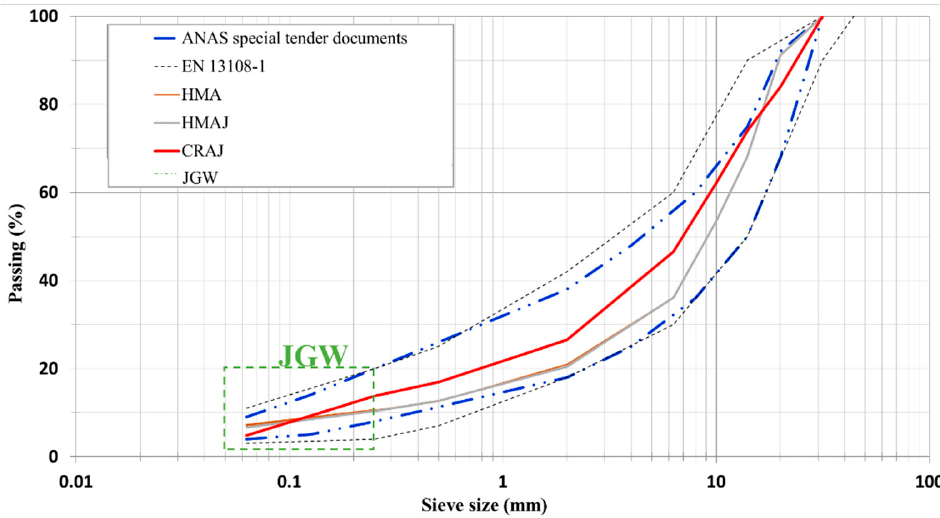
Figure 6. Grading curves for HMA, HMAJ, and CRAJ solutions vs. standard requirements.